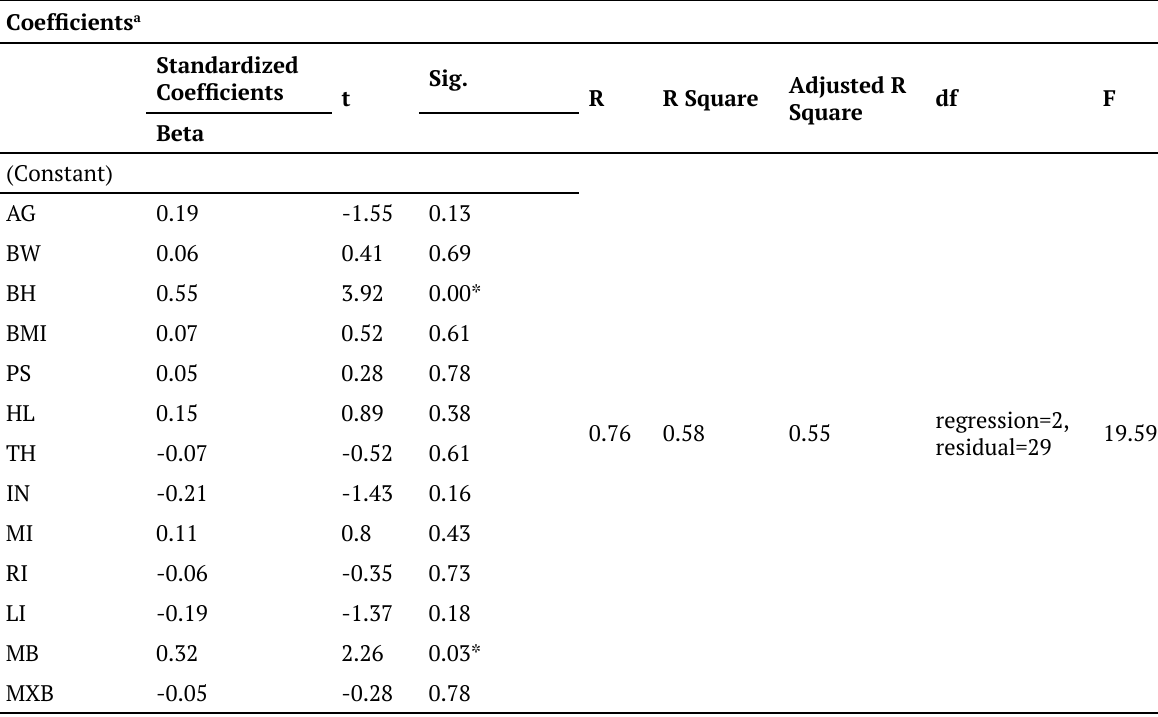
Table 4. Multiple regression analysis for anthropometric characteristics and handgrip strength in recreational tenpin bowlers